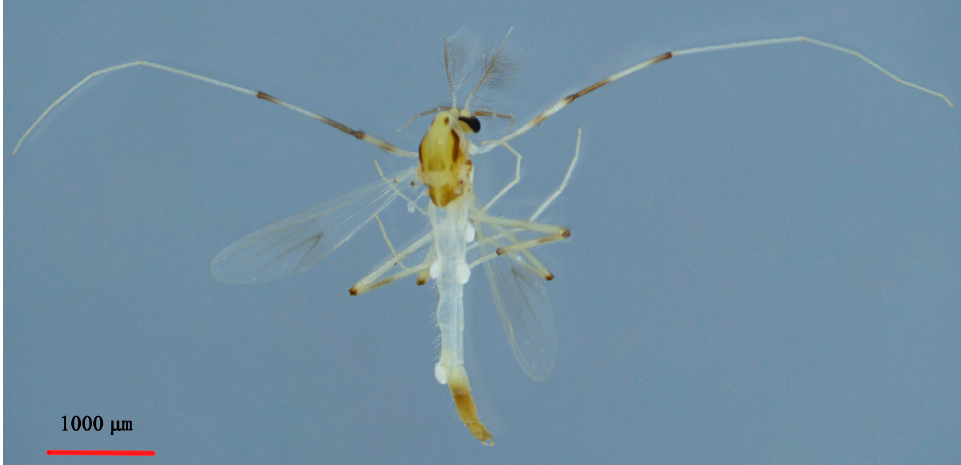
Figure 6. Male adult (holotype, in dorsal view) of Microtendipes bimaculatus sp. nov.